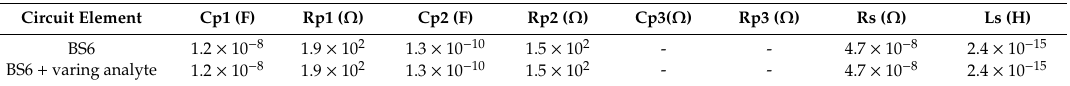
Table A9. Modeled impedance parameters Cp1, Rp1, Cp2, Rp2, Cp3, Rp3, Rs, and Ls of biochip BS6, with DI water and S. cerevisiae .